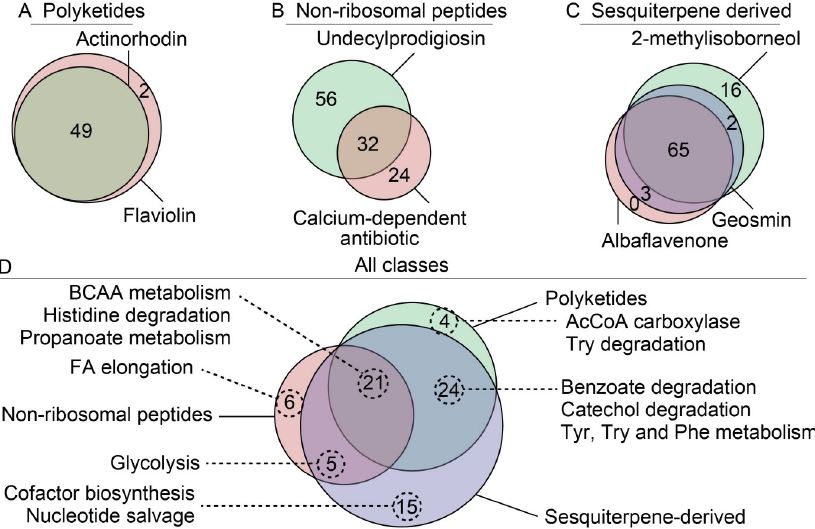
Fig 6. Venn diagrams of targets predicted to be beneficial for overproduction of various secondary metabolites by FSEOF. The 7 secondary metabolites that Sco4 can produce are grouped (A-C), and the overlap of target reactions are indicated within each group. Reactions that overlap within each group are subsequently compared between all groups (D), including in which pathways these reactions are involved. BCAA: branch-chain amino acid; TPI: triosephosphate isomerase; MEP/DOXP: mevalonate independent